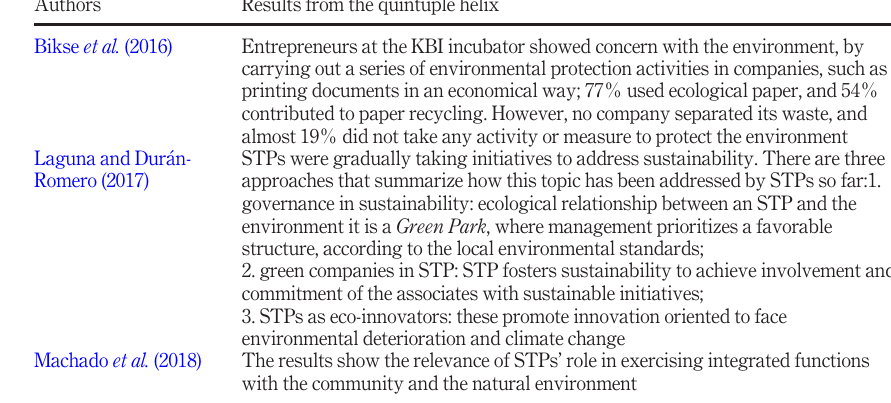
Table 6. Results from quintuple helix